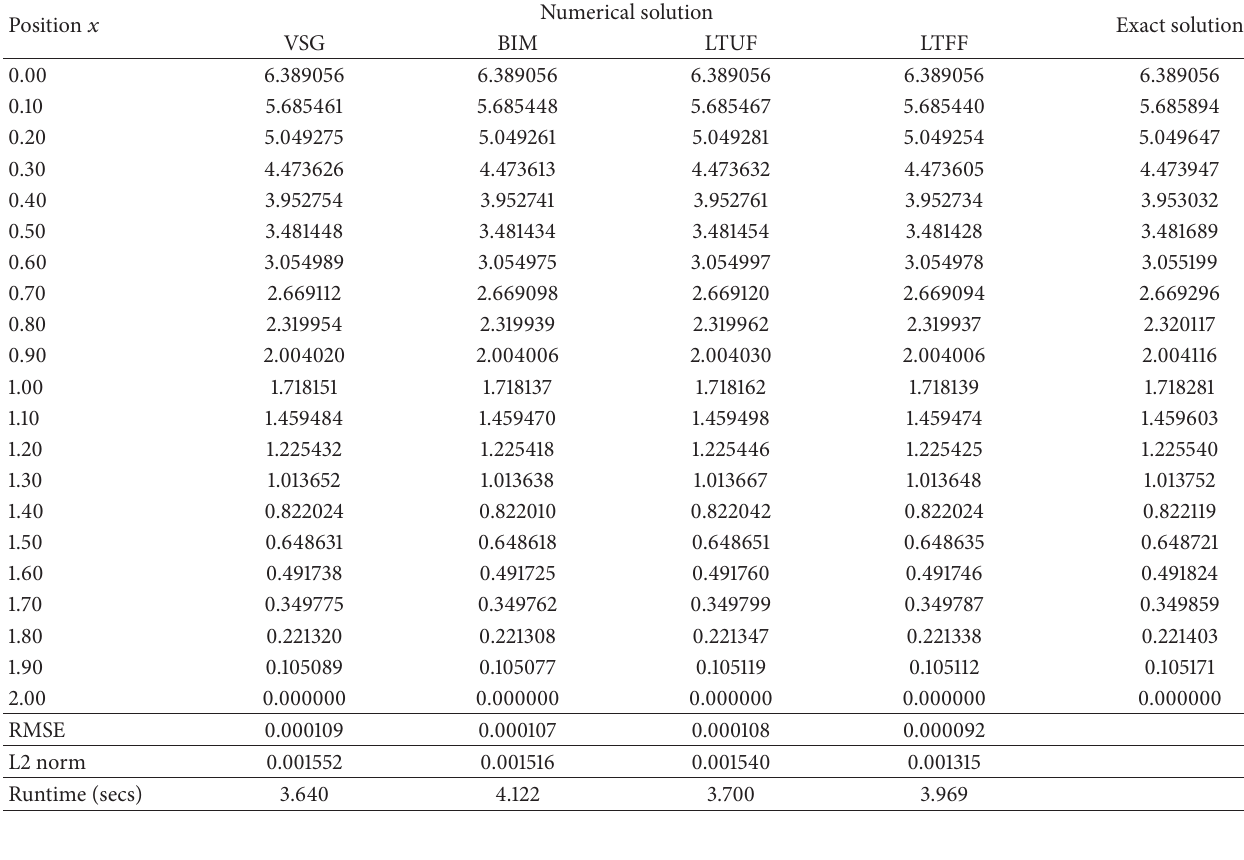
Table 6: Comparison of VSG, BIM, LTUF, LTFF method, and exact solution when 𝑓(𝑡) = exp (𝑡 + 1)